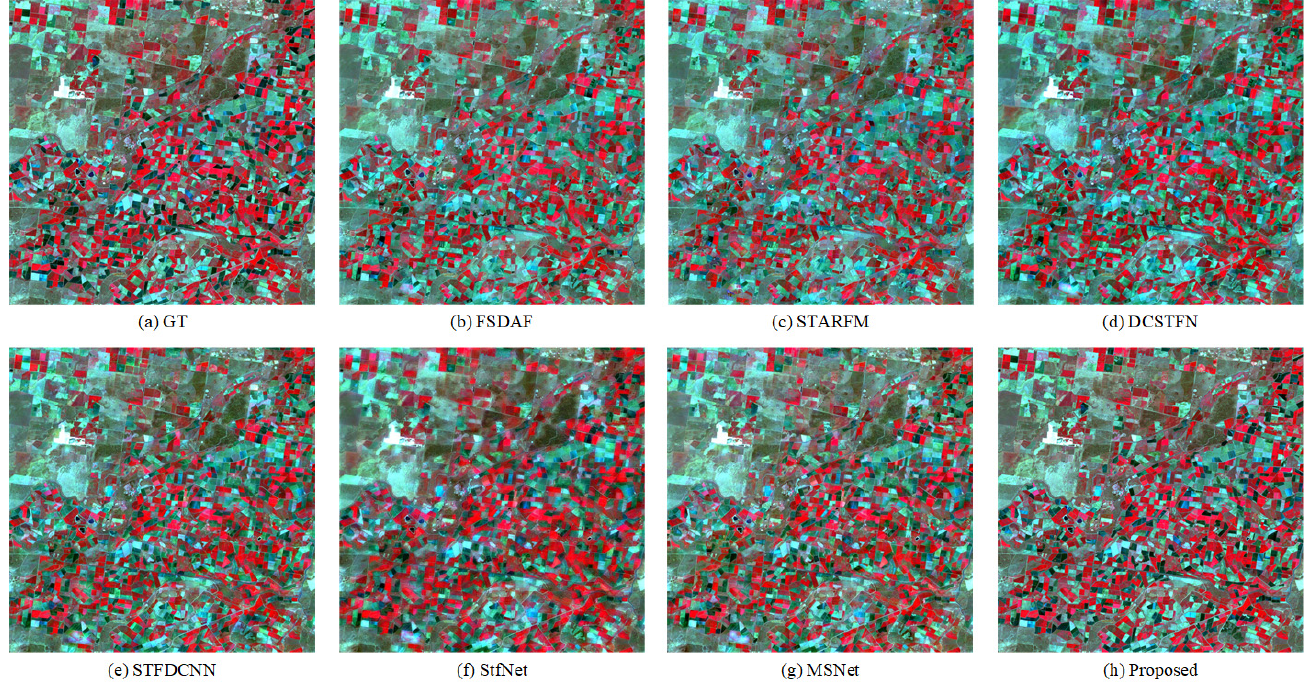
Figure 7. Entire prediction results for the target Landsat image (16 October 2001) in the CIA dataset. Comparison methods include FSDAF [11], STARFM [8], DCSTFN [23], STFDCNN [18], StfNet [19], and MSNet [36], which are represented by ( b – g ) in the figure respectively. ( a ) represents the ground truth (GT), and ( h ) represents the proposed